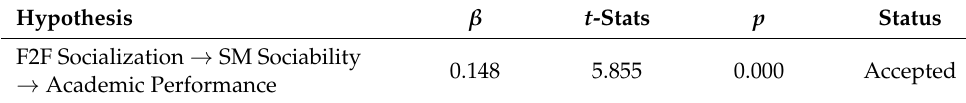
Table 11. Specific indirect path.